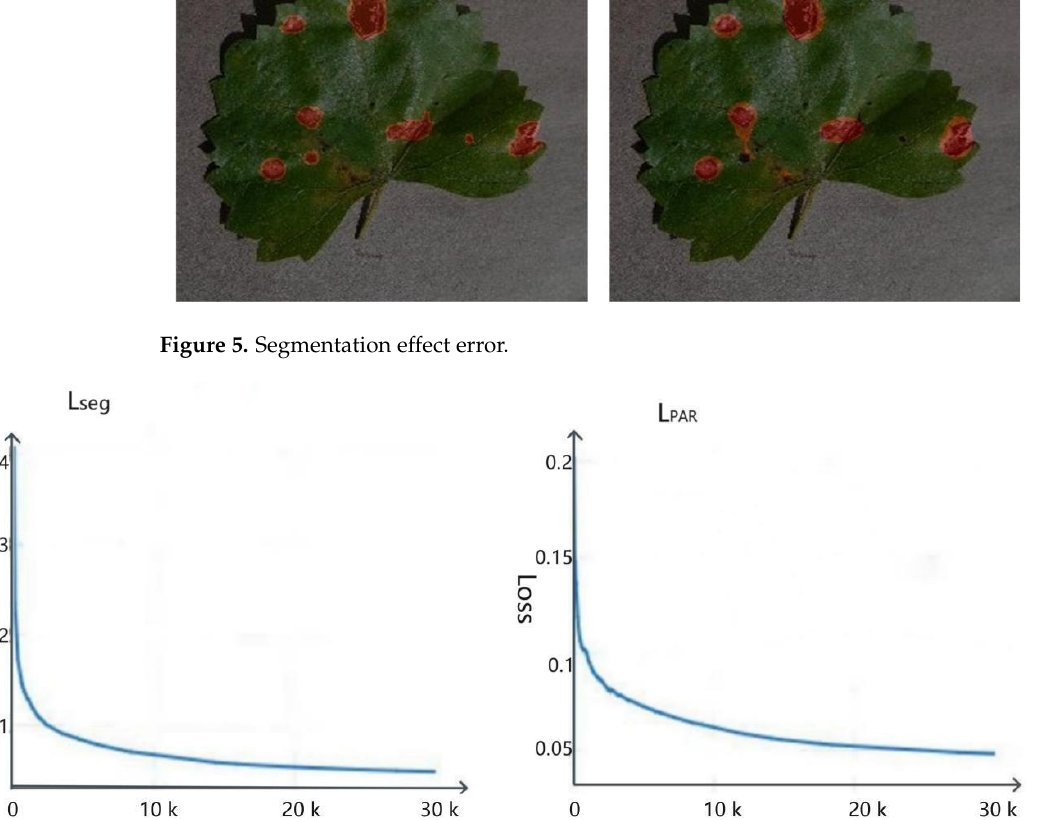
Figure 5. Segmentation effect error.